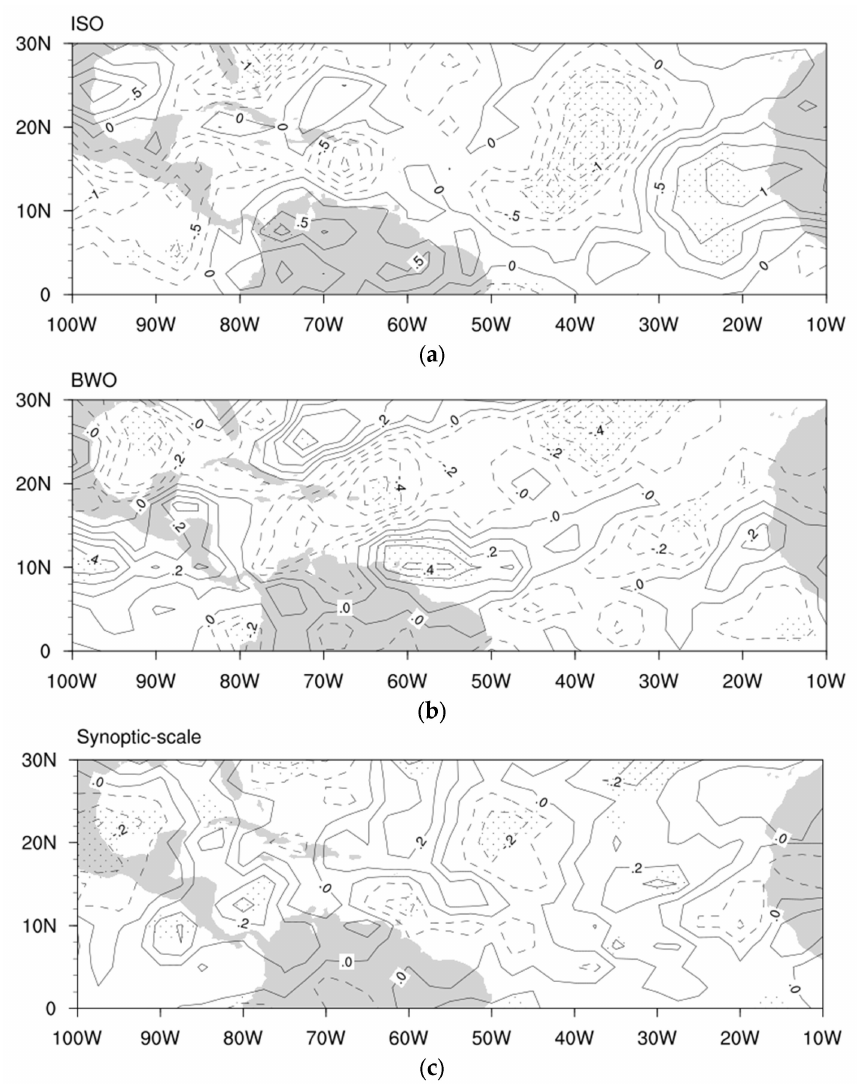
Figure 8. Anomaly fields at ( a ) 20–70 days, ( b ) 10–20 days and ( c ) 3–10 days bandpass-filtered OLR groups (unit: Wm − 2 ) which are composed of STC active and inactive years. The solid lines and dashed lines represent positive and negative anomalies, respectively. Dotted areas on the anomaly fields indicate the differences exceed the 95% confidence intervals which were constructed by a 1000-sample